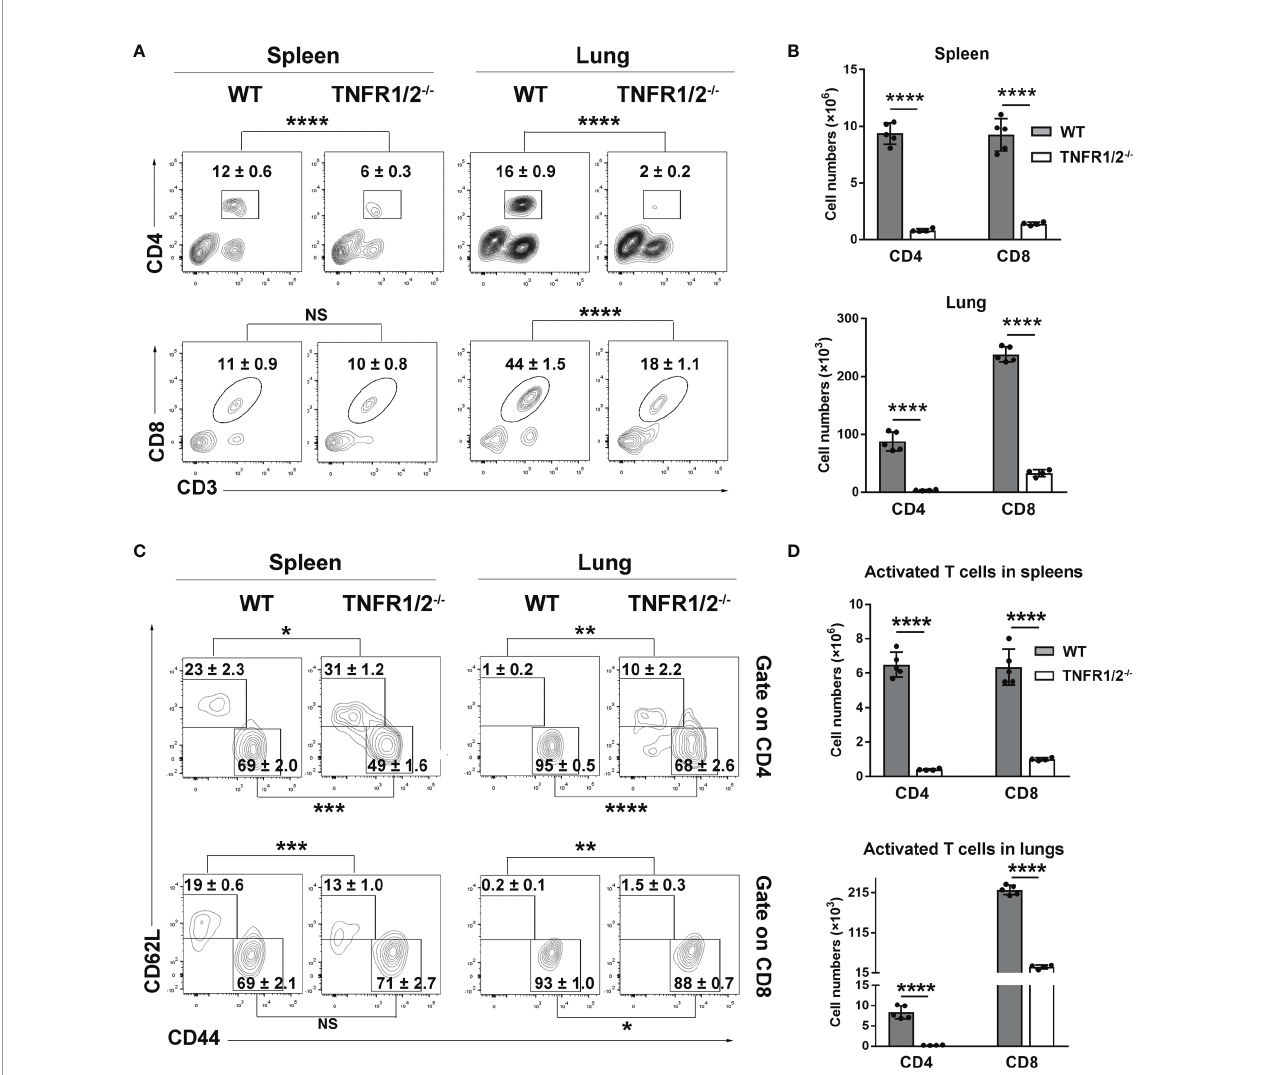
FIGURE 4 | De fi ciency of TNFR1/2 led to greatly impaired T cell responses in infection. Mice (4-5/group) were infected and harvested at D8, as in Figure 2 . Leukocytes were isolated from spleens and lungs, stained, and analyzed by fl ow cytometry. (A, B) The percentages and numbers of CD4 + and CD8 + T cells. (C, D) The percentages and numbers of activated (CD44 + CD62L - ) CD4 + and CD8 + T cells. Data are shown as mean ± SD from single experiments and are representative of at least two experiments performed. A two-tailed student t test was used for comparison of two groups. * p <0.05; ** p <0.01; *** p <0.001; **** p <0.0001; NS, not signi fi